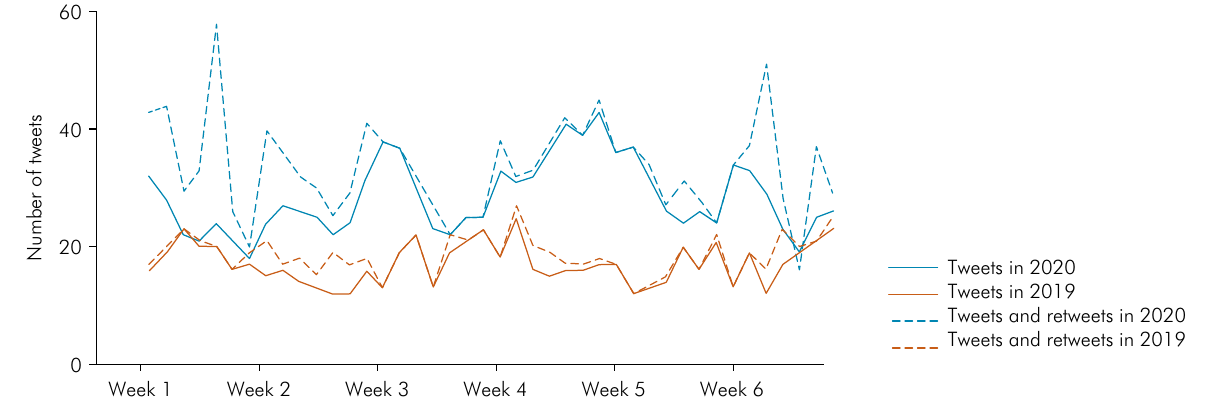
Figure 2. Temporal trends in tweets and retweets related to self-reported dental treatment needs from March 23 to May 4, 2020 (COVID-19 outbreak) and 2019.